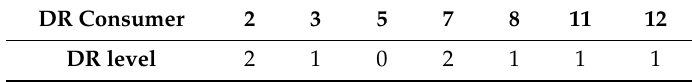
Table A3. Solutions found by the MOPSO ‐ DR algorithm. Consumer Index